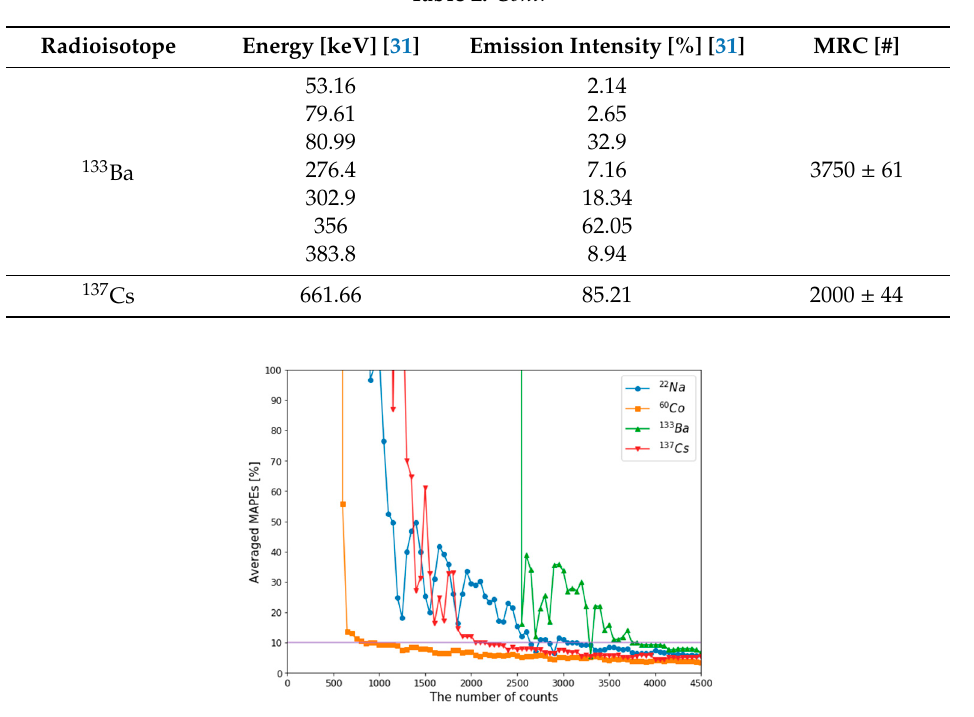
11 of 16 Figure 8 . Results of Compton edge reconstruction for experimental data. Each figure represents measured spectra of ( a ) 22 Na; ( b ) 60 Co; ( c ) 133 Ba; ( d ) 137 Cs; ( e ) 22 Na and 60 Co; ( f ) 22 Na and 133 Ba; ( g ) 22 Na and 137 Cs; ( h ) 60 Co and 133 Ba; ( i ) 60 Co and 137 Cs; ( j ) 133 Ba and 137 Cs; ( k ) 22 Na, 60 Co and 133 Ba; ( l ) 22 Na, 60 Co and 137 Cs; ( m ) 22 Na, 133 Ba and 137 Cs; ( n ) 60 Co, 133 Ba and 137 Cs; and ( o ) 22 Na, 60 Co, 133 Ba, and 137 Cs. 3.3. Minimum Reconstructible Counts Similar to minimum detectable activity [29], the number of counts required to reconstruct Compton edges in plastic gamma spectra should be verified. In previous studies on gamma (or pseudo gamma) spectroscopy, similar concepts were defined to evaluate performance according to the activity of radioactive sources or the number of counts in their detection systems [12,30]. However, these cannot be used directly in our study because of the differences in their detailed concepts. Instead, averaged MAPE was used as a quality factor to evaluate the minimum reconstructible count (MRC) of the trained autoencoder. For each radioisotope, averaged MAPEs between reconstruction results and reconstruction references were calculated as follows. First, measured spectra in Section 3.2 (i.e., input spectra in Figure 8a–c) were normalized and utilized as PDFs for generating test sets for MRC evaluation. Second, 100 spectra were generated as test sets with the procedure detailed in section 2.2 for each number of counts. Third, Compton edges were reconstructed for the test sets. Fourth, MAPEs between reconstruction results and reconstruction references were calculated for 100 generated spectra, and the averaged MAPE value was calculated. In this study, the reconstruction results presented in Section 3.2 (i.e., reconstructed spectra in Figure 8a–c) were used as a reconstruction reference. The threshold for MRC was determined as 10% of the averaged MAPE by referring to Table 1. Whole steps for MRC evaluation above were iterated with